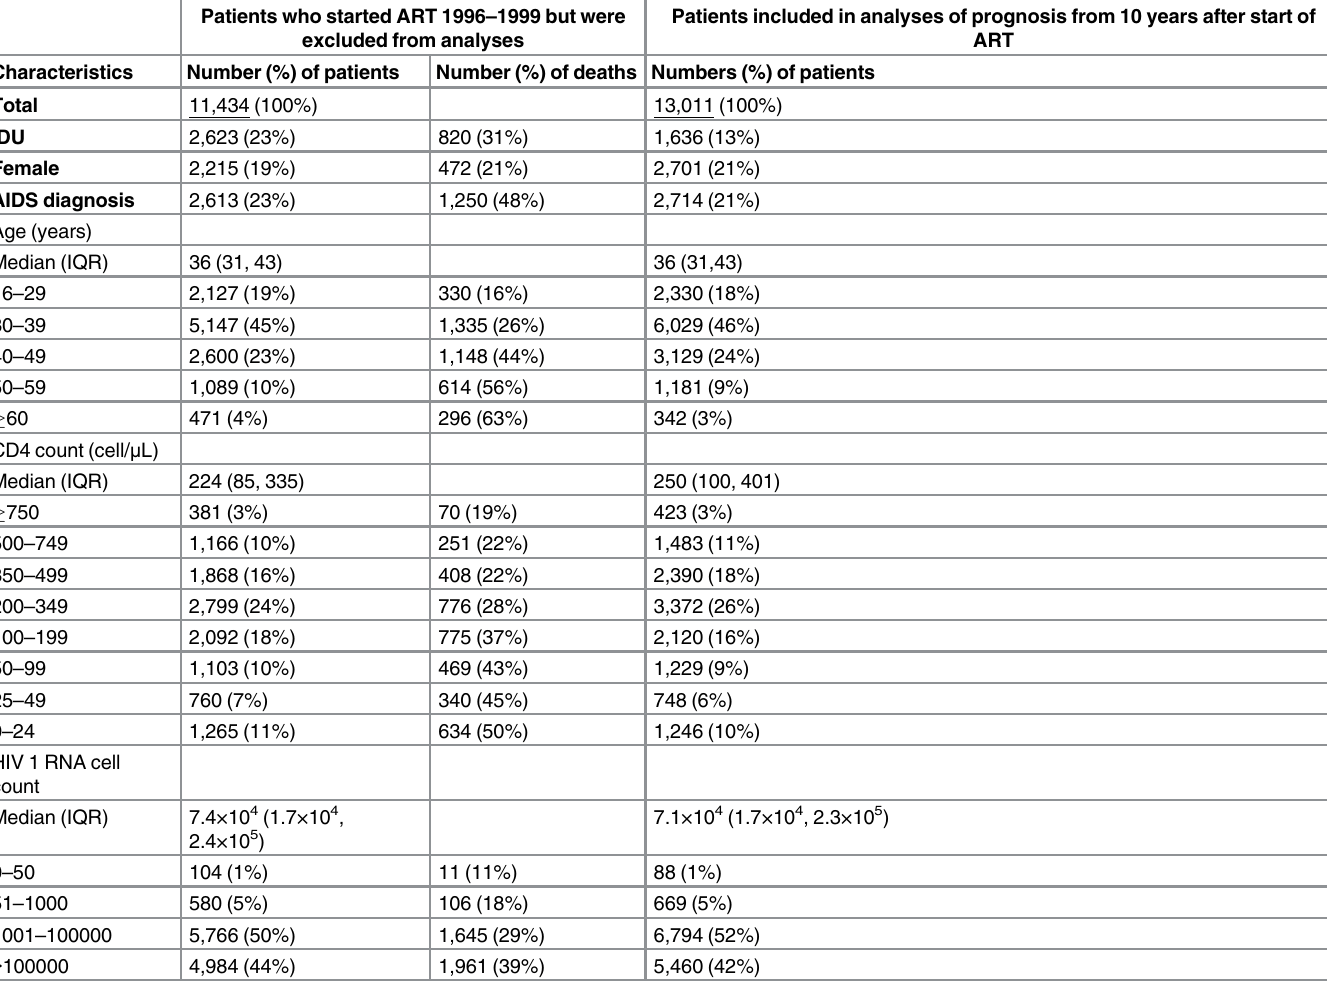
Table 1. Characteristics (at start of ART) of patients who were and were not eligible for analyses of prognosis from 10 years after start of ART. Patients who started ART 1996 – 1999 but were Patients included in analyses of prognosis from 10 years after start of excluded from analyses